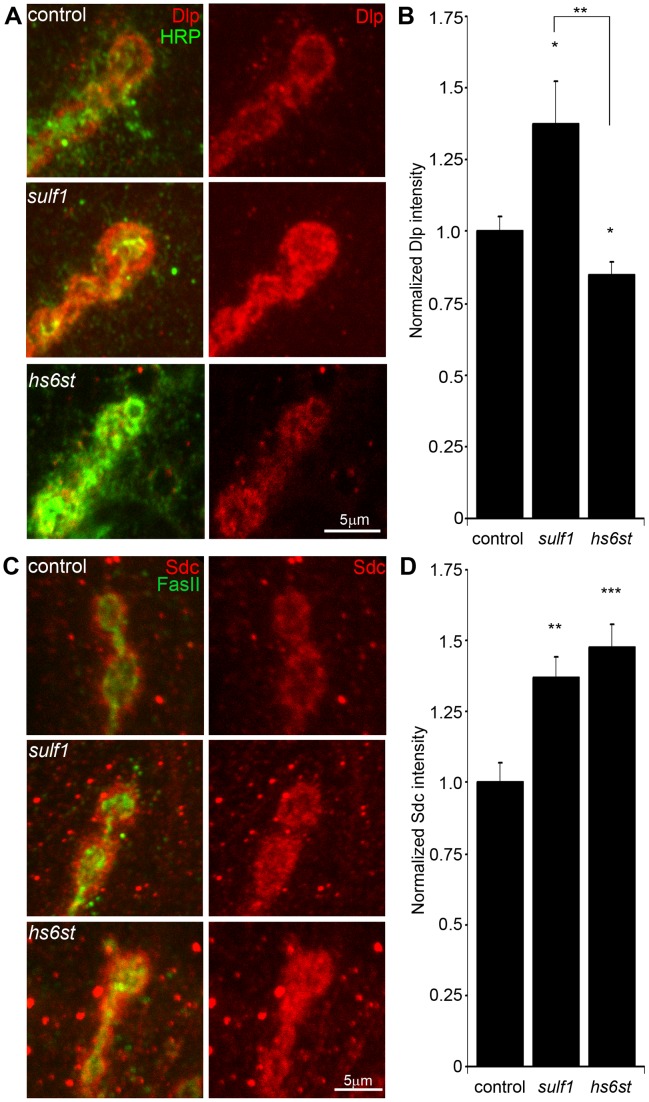
Synaptic HSPG co-receptor abundance is modified by 6-O-S sulfation.(A) Representative NMJ synaptic boutons imaged from control (w1118), sulf1 and hs6st nulls, probed with presynaptic neural marker anti-HRP (green) and Dally-like (Dlp; red). Right: Dlp distribution without the HRP signal is shown for clarity. (B) Quantification of mean fluorescent intensity levels of anti-Dlp labeling normalized to the HRP co-label at the muscle 6 NMJ, normalized to genetic control. (C) Boutons labeled with neural marker anti-Fasciclin II (FasII, green) and anti-Syndecan (Sdc, red). Right: Sdc distribution is shown alone for clarity. (D) Quantification of the mean fluorescent intensity levels of anti-Sdc labeling at the muscle 6 NMJ, normalized to genetic control. Sample sizes are at least 12 independent NMJs of at least 7 animals per indicated genotypes. Statistically significant differences calculated using student's t-test, * p<0.01, ** p<0.01, ***p<0.001. Error bars indicate S.E.M.